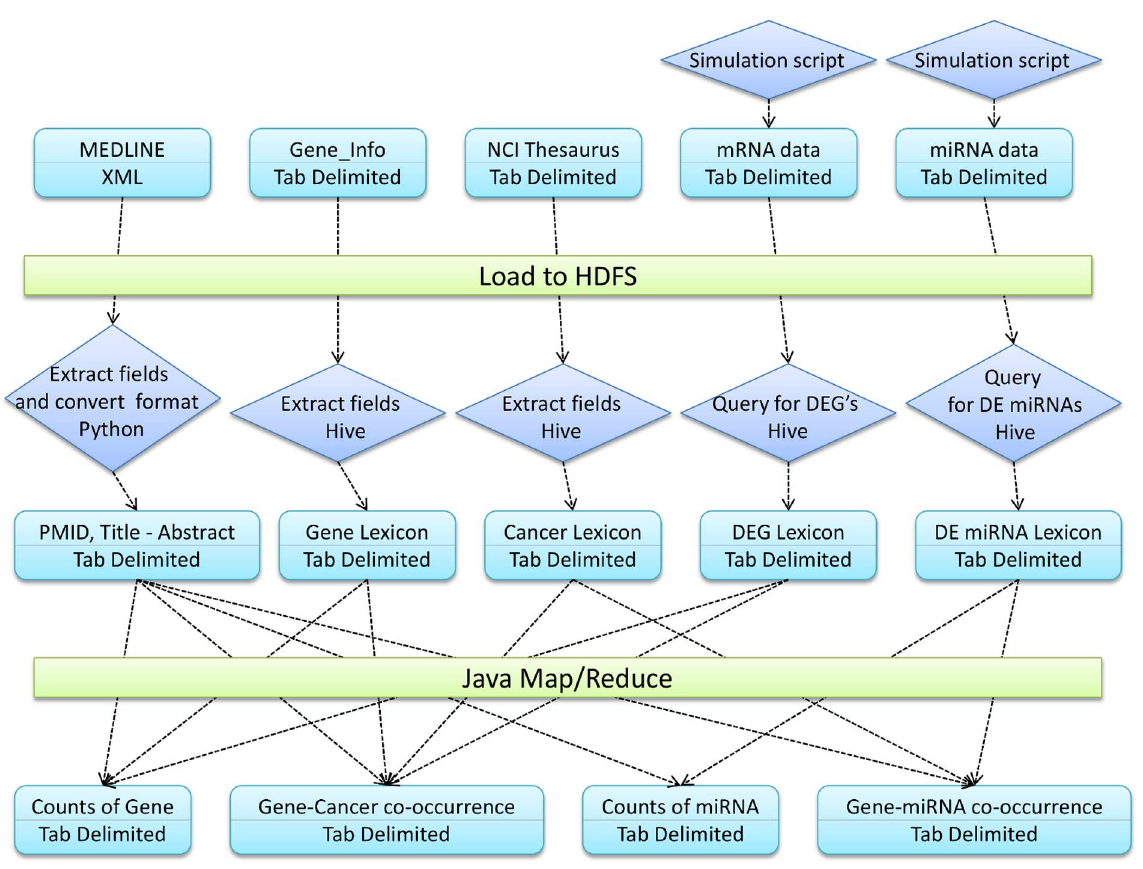
Figure 5. Architecture for integrating structured and unstructured data in Hadoop. Architectural diagram detailing the steps in creating the categorical lexicons and using them to get the PMID counts from literature. DEG stands for Differentially Expressed Gene while DE miRNA stands for Differentially Expressed miRNA.